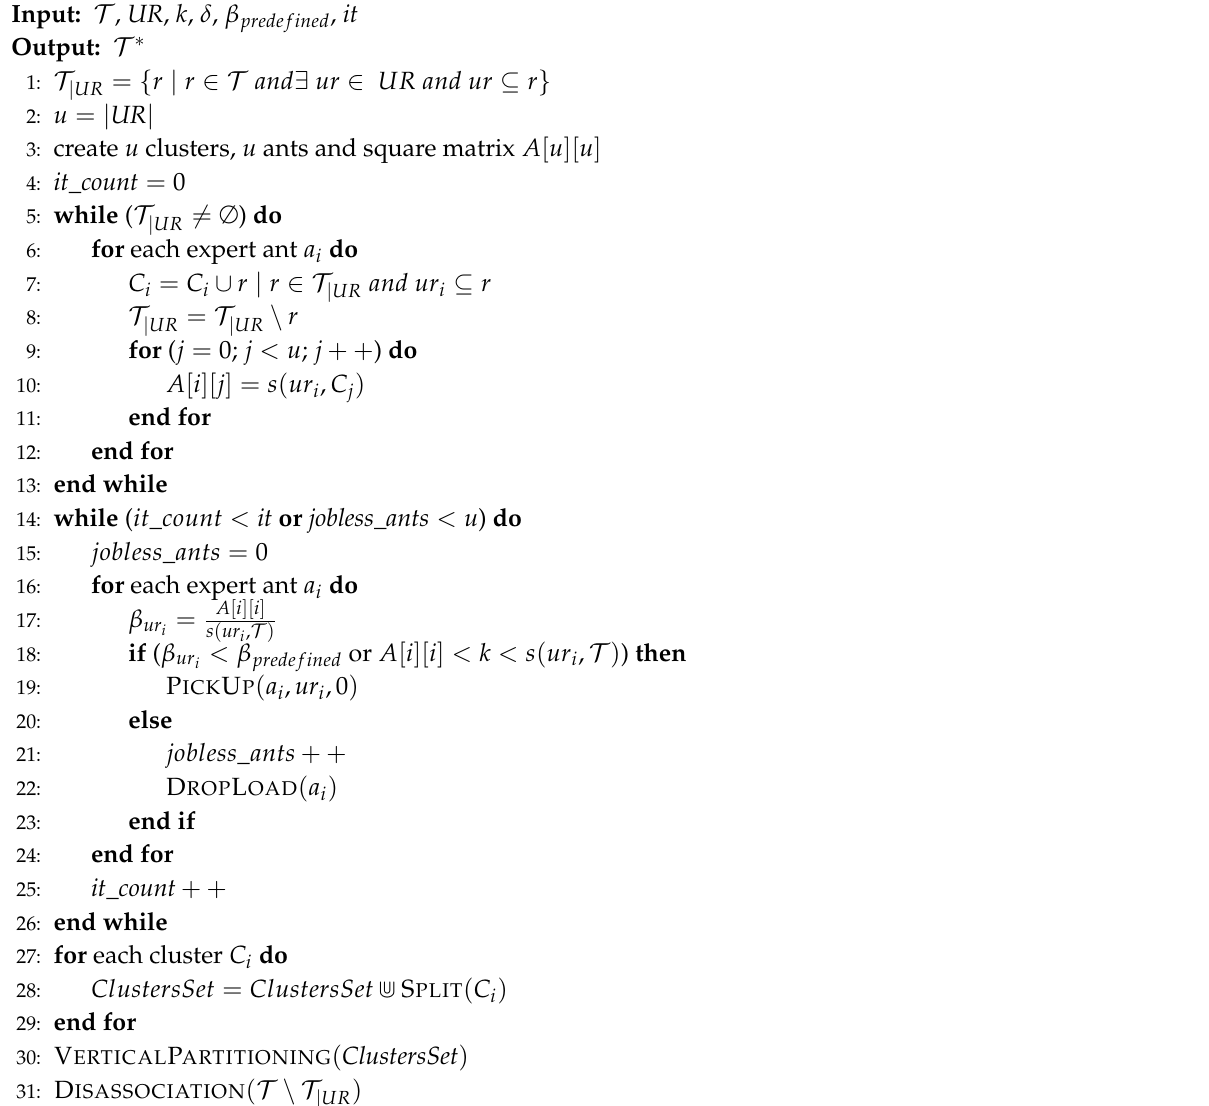
Algorithm 1 Utility guided ant-based clustering algorithm